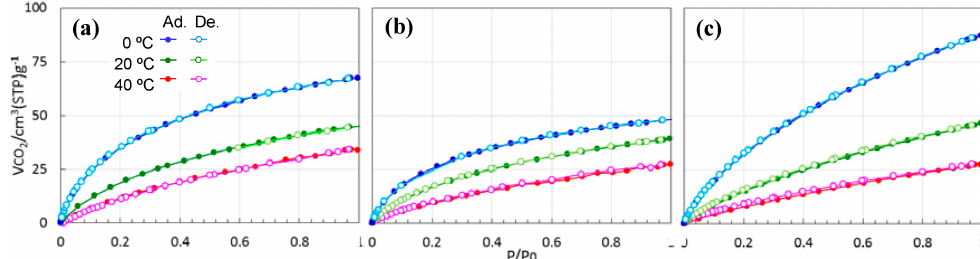
Figure 11. Temperature dependence of CO 2 isotherm for ( a ) EtOSZ pyrolyzed at ( a ) 600 ◦ C; ( b ) 800 ◦ C and ( c ) DHNpOSZ pyrolyzed at 550 ◦ C.